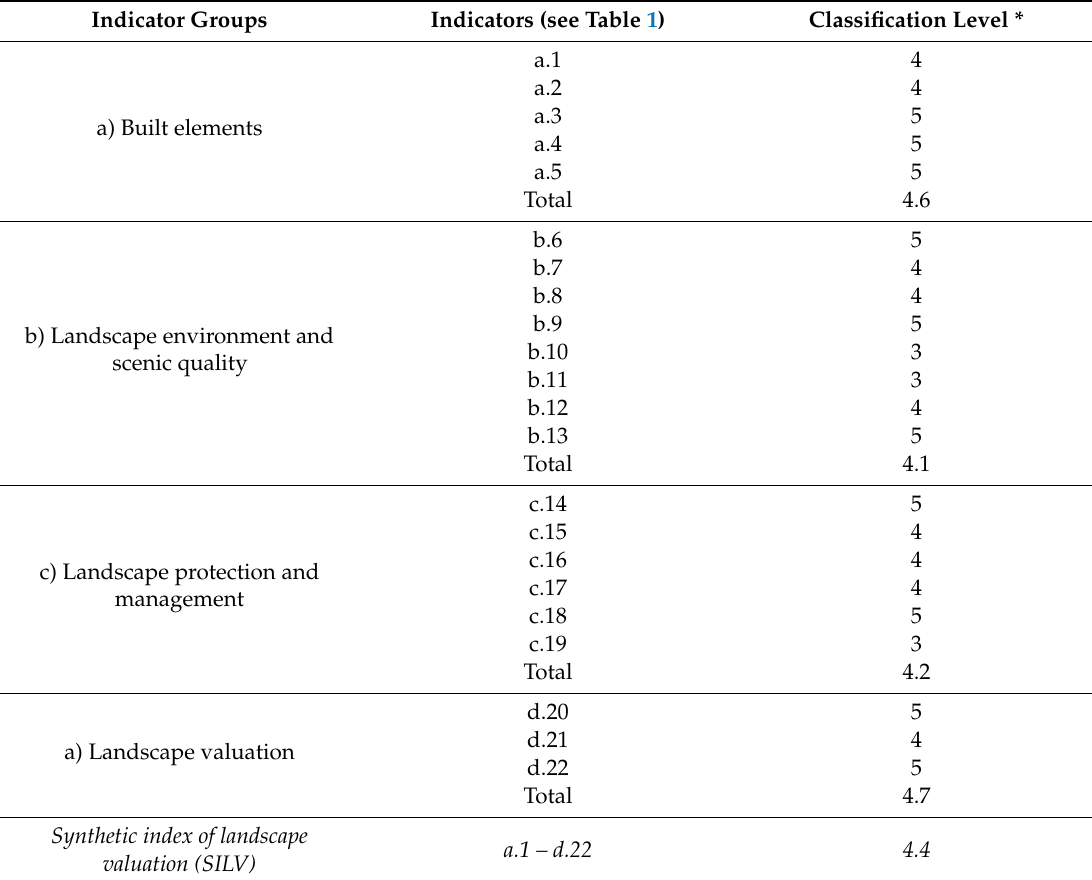
Table 3. Classification levels of the landscape indicators